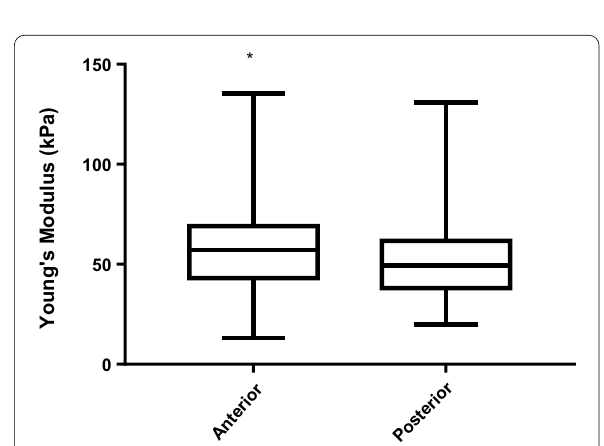
Fig. 4 Box and Whisker plot of mean YM measurements in anterior and posterior CCA wall